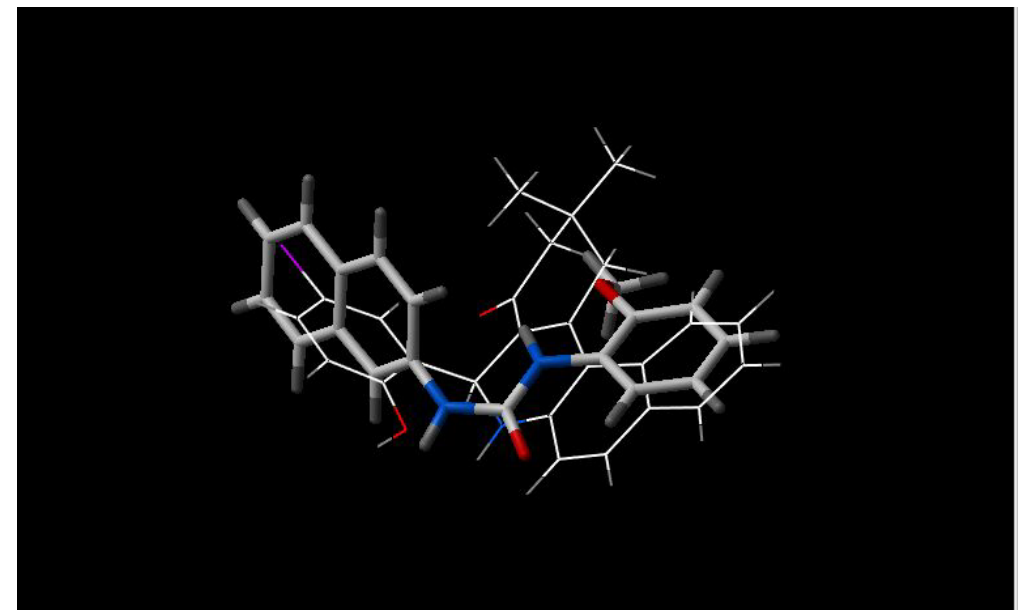
Figure 2. Best fit of optimised INF 271 (sticks) and INF 277 (wireframe) structures.